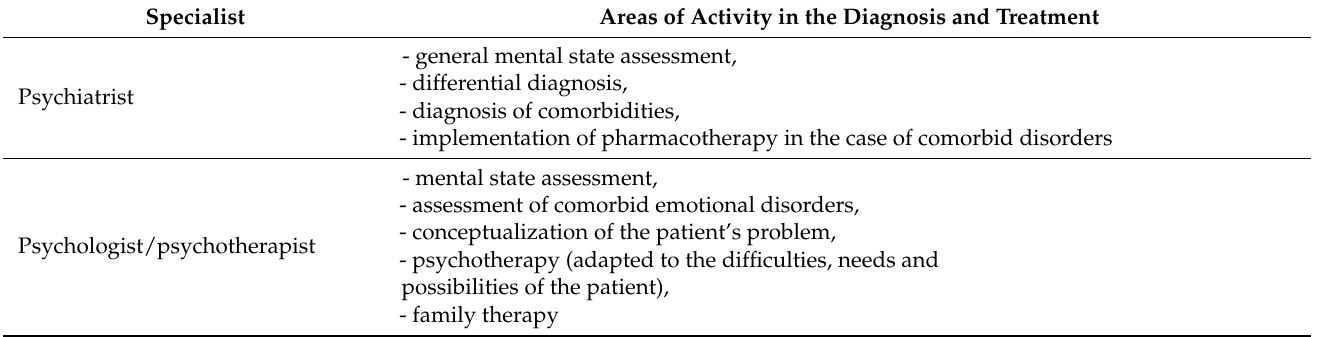
Table 2. List of areas of activity in the diagnosis and treatment of eating